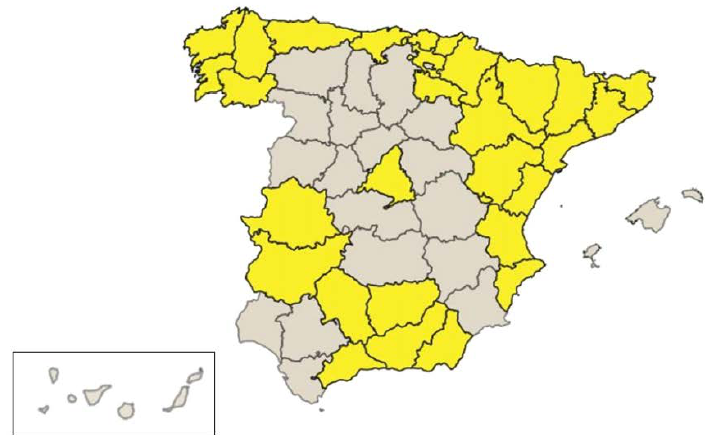
Figure 1. Spanish provinces selected for the study.